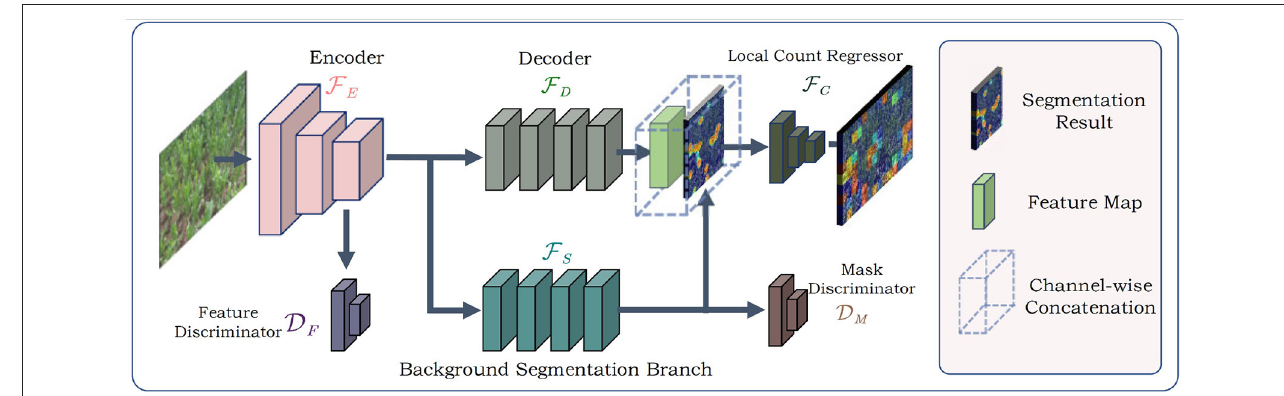
FIGURE 4 | The overview of our method. The BADA module works as a parallel branch in the CNN model. Two discriminators are connected to the input and output of BADA model and are imposed with adversarial training strategies.